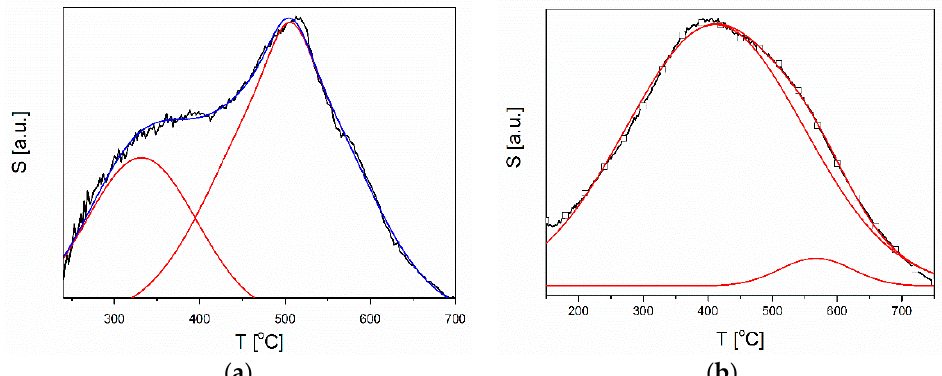
Figure 10. Sensitivity simulation to 2 ppm Cl 2 as a function of temperature of: ( a ) powder and ( b ) microrods. ( b )